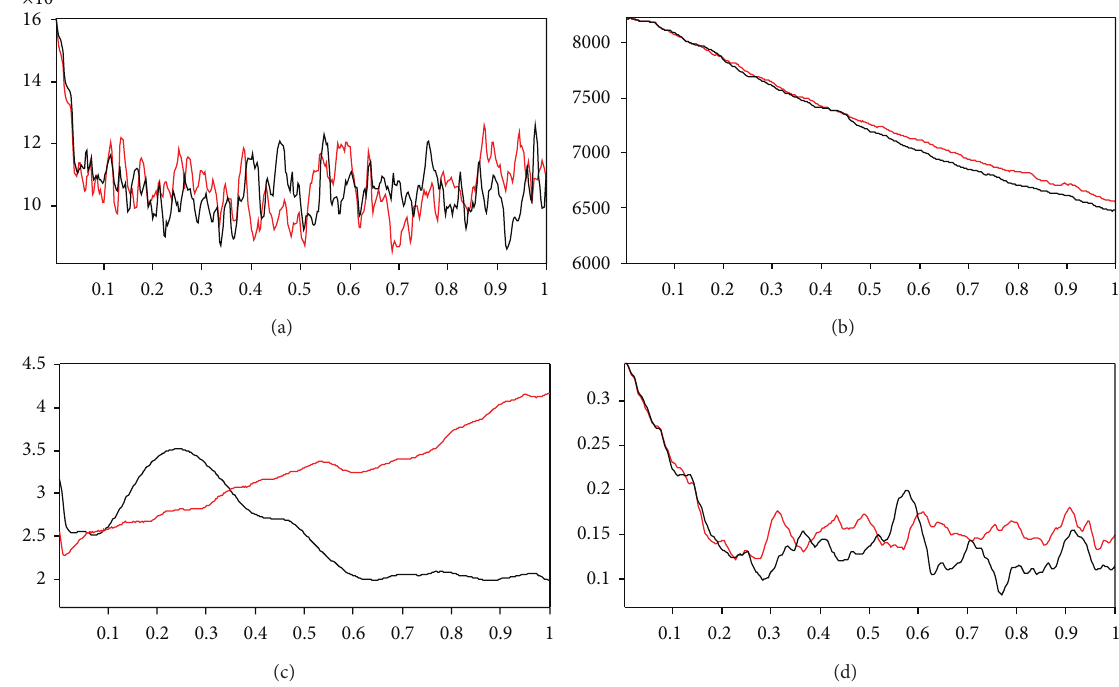
Figure 12: Time series of RMSEs of (a) atmospheric stream function, (b) oceanic stream function, (c) sea surface temperature, and (d) land surface temperature for GDF (black curve) and DF with 𝑎, 𝑏 = 0.5 (red curve).